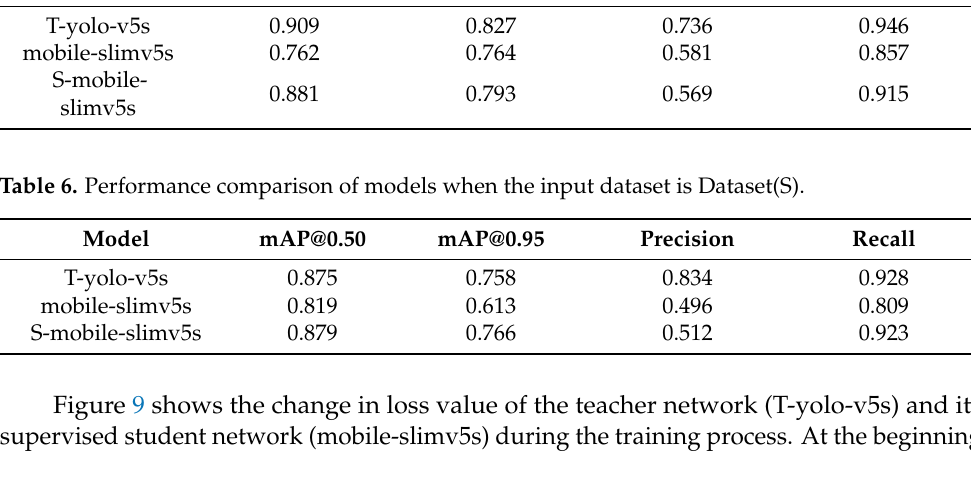
Table 5. Performance comparison of models when the input dataset is Dataset(T). Model